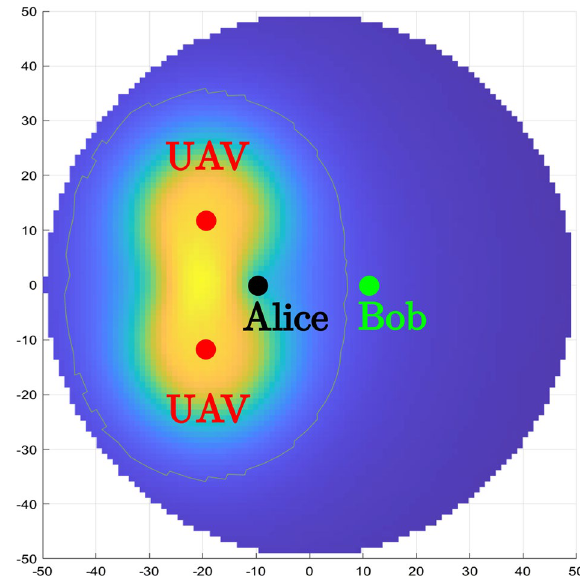
Fig. 2 Heatmap for (cid:31) values due to the presence of UAV jammers on a circular region around